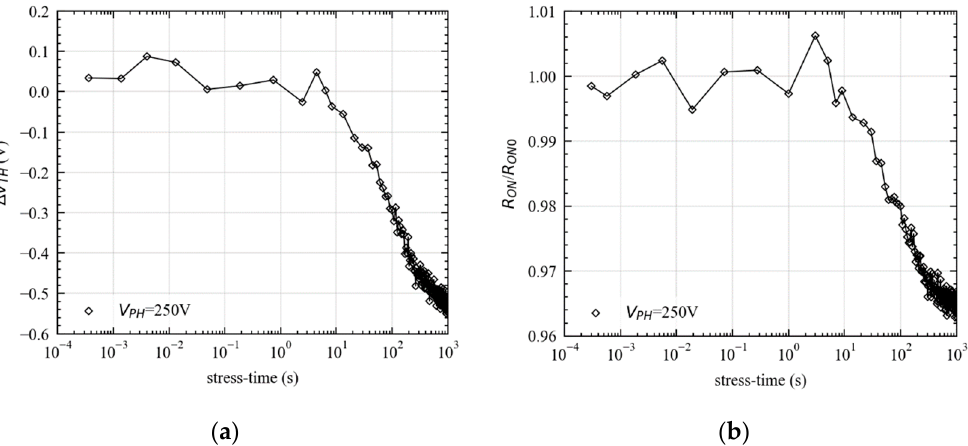
Figure 5. Results obtained with ( V GL ; V GH ) = ( − 5 V; 20 V) and ( V PL ; V PH ) = (3 V; 250 V). ( a ) ∆ V TH (i.e., V TH – V TH0 ). ( b ) Normalized R ON variation (i.e., R ON / R ON0 ).